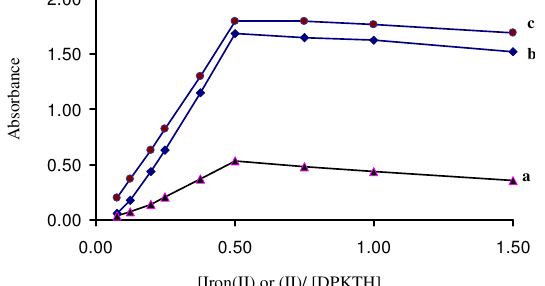
Figure 1. Job's plots to determination the molar ratios at T = 36 o C; (a) plot of absorbance vs . [Fe 2+ /DPKTH] at λ = 656 nm, [DPKTH] = 2 x 10 -4 M, [Fe 2+ ] = 0.15 - 4.5 x 10 -4 M, max 10% ethanol and pH = 4.7; ( b) Plot of absorbance vs . [Fe 3+ /DPKTH] at λ = 364 nm, max [DPKTH] = 2 x 10 -4 M, [Fe 3+ ] = 0.15 – 4.5 x 10 -4 M, 10% ethanol and pH = 4.9; (c) Plot of = 656 nm, [DPKTH] = 6 x 10 -4 M, [Cysteine] = 6 x 10 -4 M, absorbance vs . [Fe 3+ /DPKTH] at λ max [Fe 3+ ] = 0.15 – 4.5 x 10 -4 M, 10% ethanol and pH =